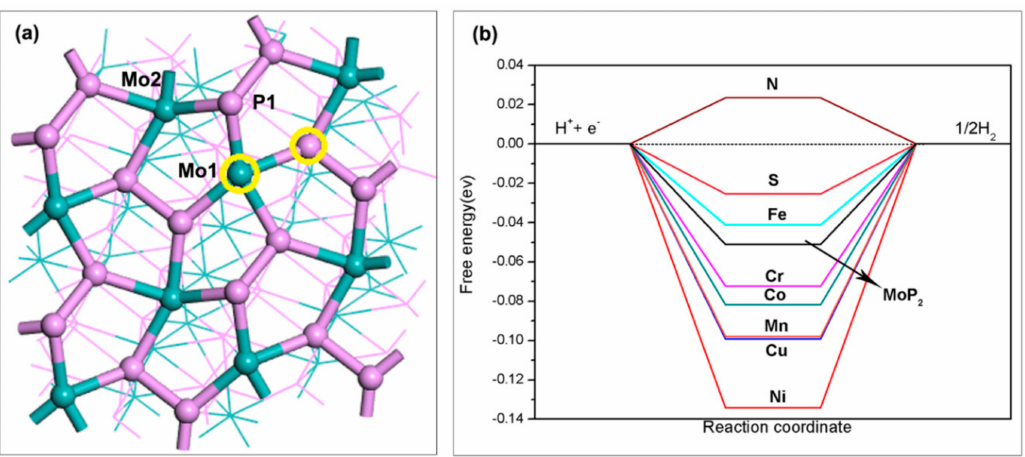
Figure 7. ( a ) Top view of the (111) facet with two doping atom sites. ( b ) Gibbs free energies of adsorption for the (111) facet and its doped facets.